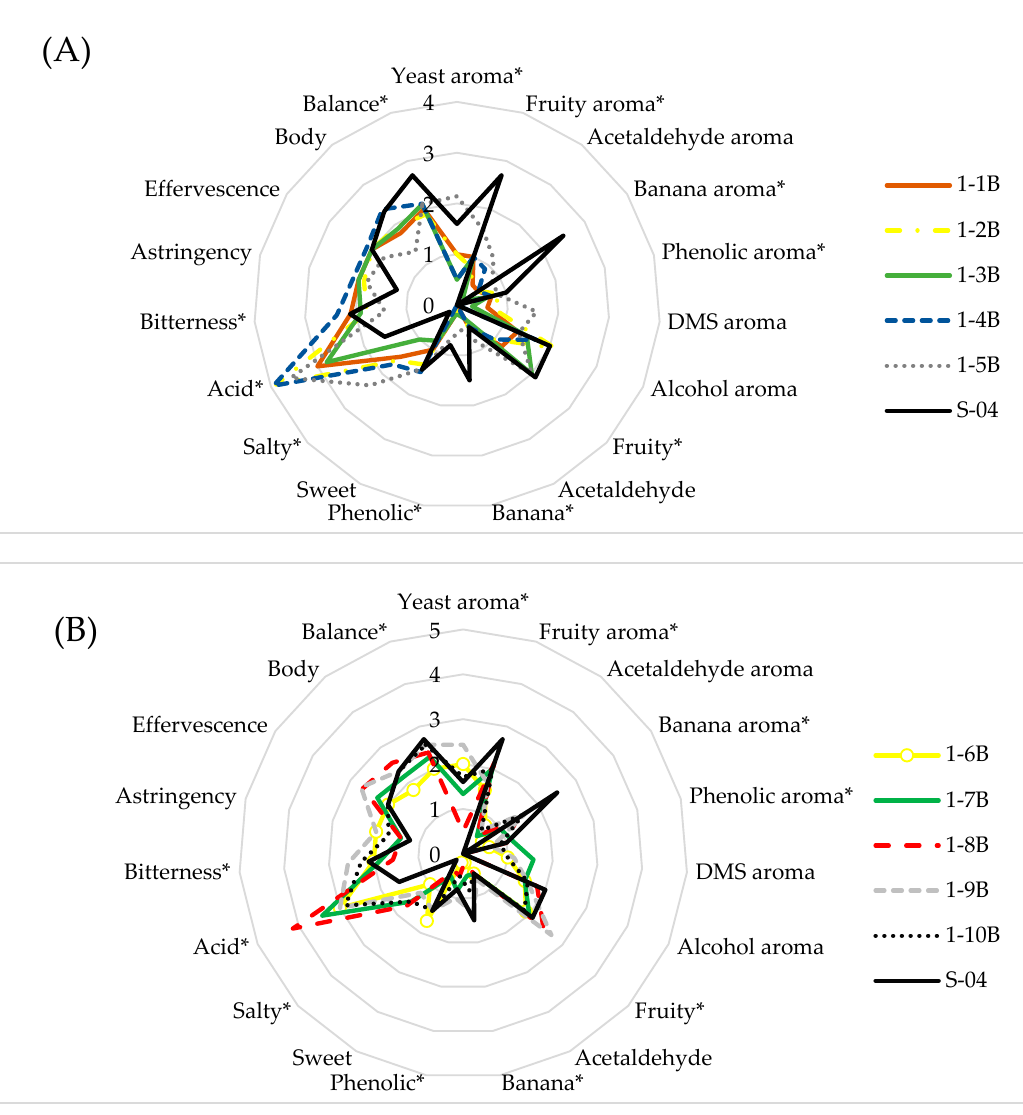
Figure 4. Sensory analysis of the 10 sour beers studied. Aroma attributes: yeast aroma, fruity aroma, acetaldehyde aroma, banana aroma, phenolic aroma, DMS (dimethyl sulphide) aroma, alcohol aroma; flavour attributes: fruity, acetaldehyde, banana, phenolic; taste attributes: sweet, salty, acid, bitterness; overall attributes: astringency, effervescence, body, balance. ( A ), sensory analysis for strains 1-1B, 1-2B, 1-3B, 1-4B, 1-5B, S-04, ( B ) sensory analysis for strains 1-6B, 1-7B, 1-8B, 1-9B, 1-10B, S-04. *: significantly different (ANOVA; p < 0.05).